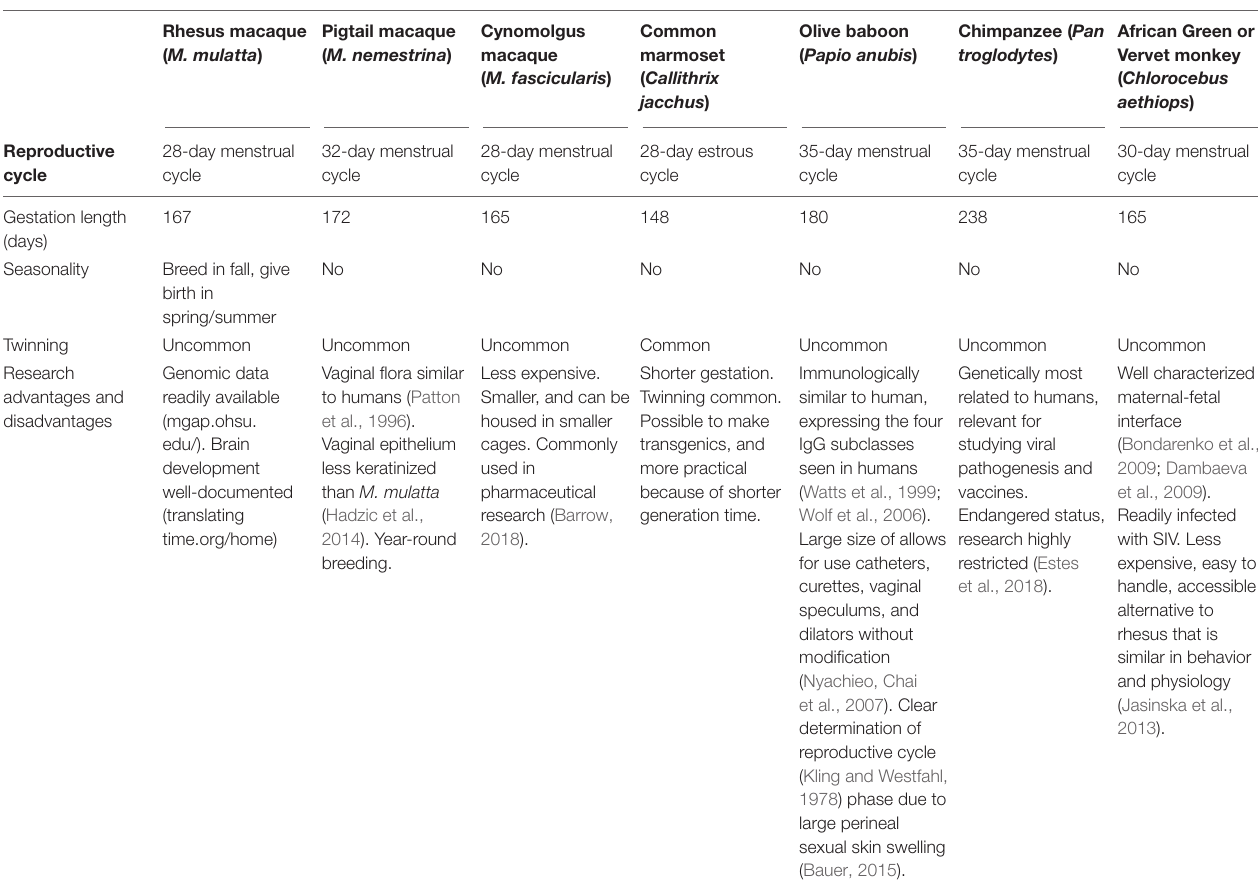
TABLE 2 | Comparison of similarities and differences with humans across common non-human primate models. Rhesus macaque ( M. mulatta